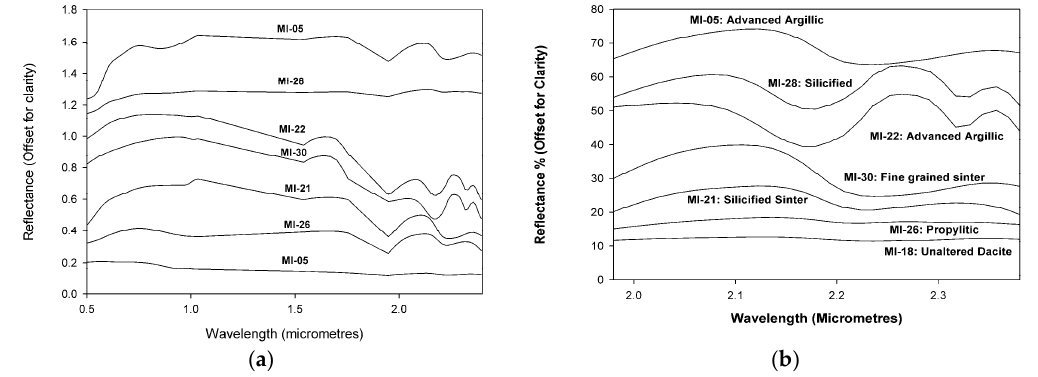
4 of 14 Figure 2. Location map of study area in western Milos showing sample locations and transect